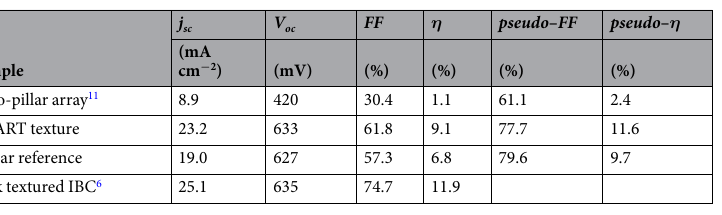
Table 1. Overview of solar cell parameters, maximum values obtained by jV characteristics of liquid phase crystallized silicon thin-film solar cells on the nano-pillar array from ref. 11, the SMART texture, parallel processed planar reference cell and back textured IBC cell from ref.